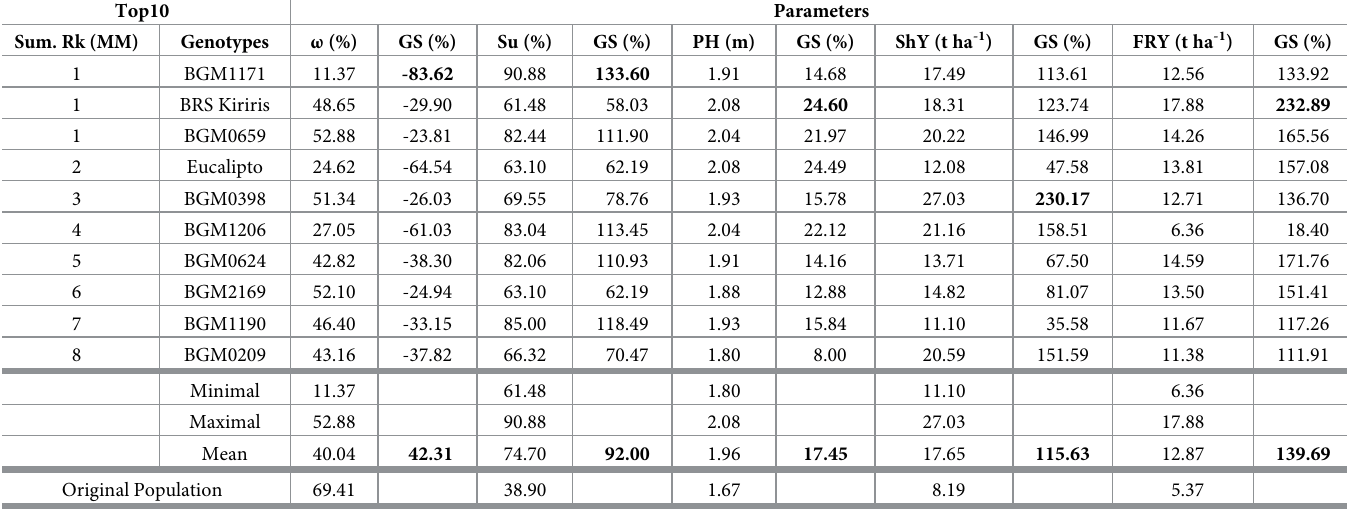
Table 2. Averages for disease index ( ω ), survival (Su), plant height (PH), shoot yield (ShY), and fresh root yield (FRY) considering only the 10 best genotypes according to the selection index and expected selection gain (GS%) relative to the original population. Top10 Sum. Rk